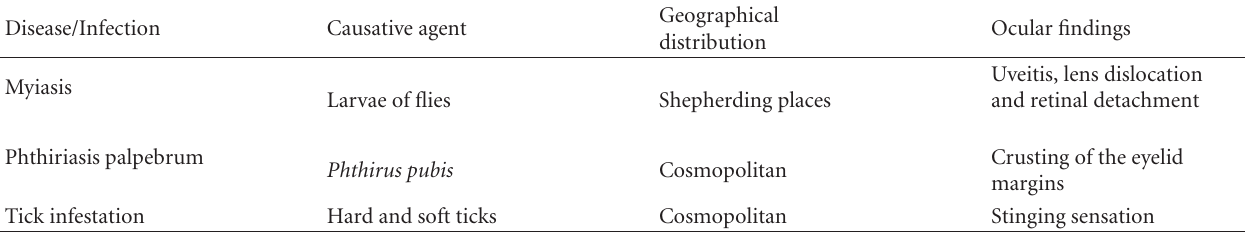
Table 7: Ocular parasitosis caused by ectoparasites ( geographical distribution & ocular findings ).